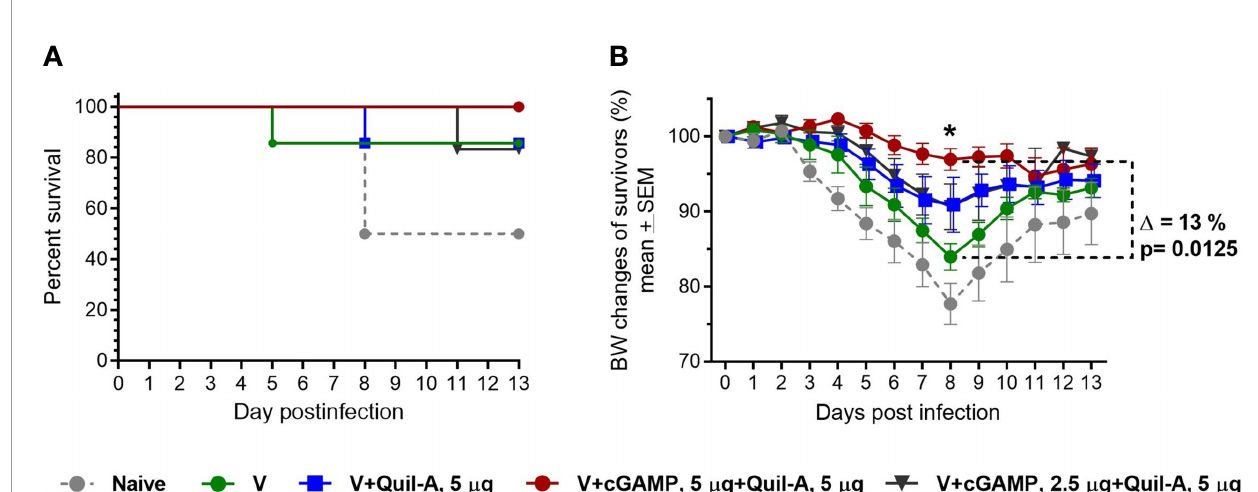
FIGURE 2 | Effect of adjuvant composition of MNPs on protection of vaccinated aged mice against challenge. Aged 21-month-old animals received a single dose (0.9 ± 0.2 µg HA) of adjuvanted or non – adjuvanted A/California 07/09 H1N1 vaccine followed by challenge with 16 pfu of the mouse-adapted in fl uenza A/California 07/09 H1N1virus 6 weeks postvaccination (n=7 in all groups except in the 5 µg Quil-A / 2.5 µg cGAMP group where one mouse expired, and in nonvaccinated group n = 6). (A) Survival, (B) Body weight of surviving mice. The statistical signi fi cance between unadjuvanted and adjuvanted MNP groups was calculated by one- way ANOVA with Tukey ’ s posttest (*p < 0.05 for Quil-A/cGAMP combination group (5 µg